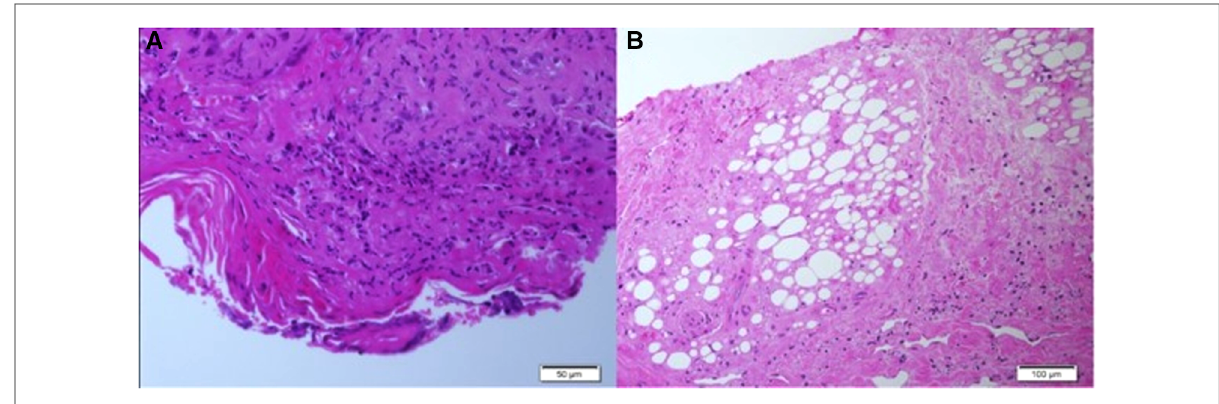
FIGURE 2 ( A,B ) Histopathological fi ndings of skin biopsies: epidermal necrosis, a mononuclear perivascular and periadenxal in fi ltrate, fat necrosis with hyalinization. Changes compatible with lipodystrophy in the dermis and subcutaneous tissue. (Figure A: H&E, ×50, Figure B: H&E, ×100).